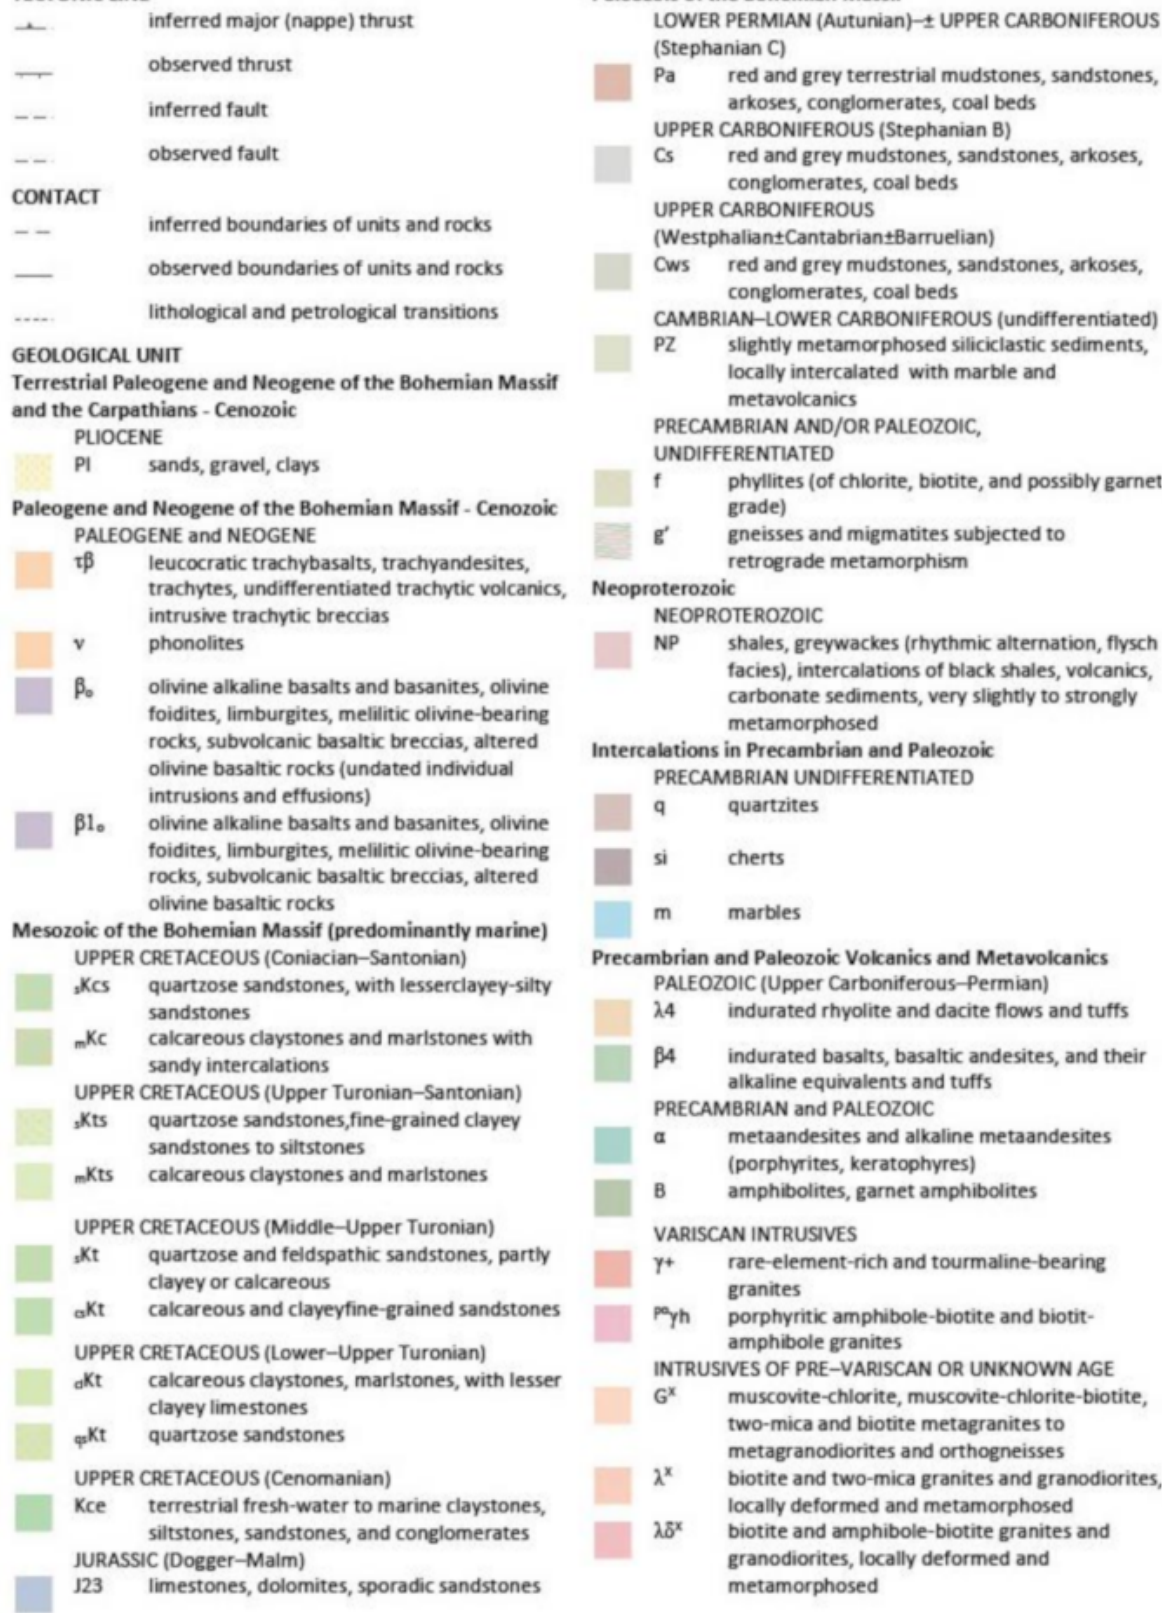
Figure 3. The geological map of the Bohemian Paradise UNESCO Global Geopark. Source: Czech Geological Survey